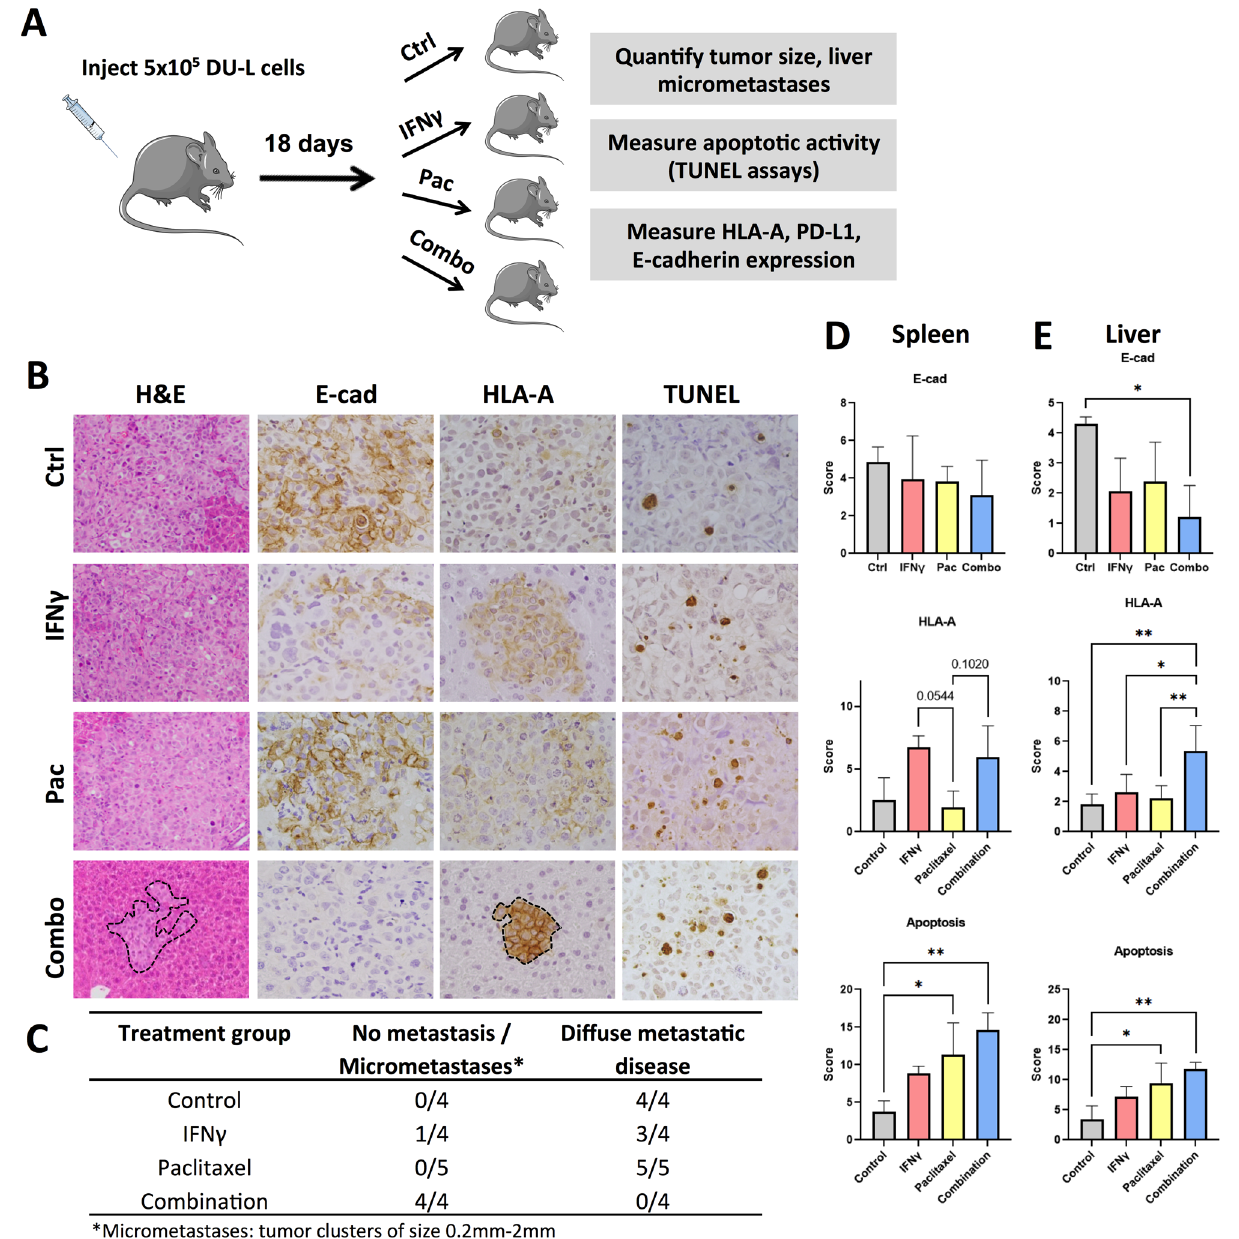
Figure 3. Alterations in HLA-A and E-cadherin expression and chemosensitivity of mCRPC after IFNγ pretreatment in vivo. ( A ) Experimental outline to test the effect of IFNγ pretreatment on HLA-A and E-cadherin expression, as well as sensitivity to chemotherapy in DU-L cells in vivo. ( B ) Limited liver metastatic tumor growth of DU-L prostate cancer cells in IFNγ and paclitaxel combination group. H&E images at 200 × magnification and all others at 400 × magnification. Tumor is not outlined where the vast majority of the captured image is tumor. ( C ) Enumeration of liver metastasis in each mouse. ( D ) Representative H&E, HLA- A, E-cadherin and TUNEL staining in the metastatic tumors at completion of the study. ( E ) Quantification of HLA-A and E-cadherin expression, and TUNEL assays. Data shown as mean ± SD. Analysis of variance (ANOVA) or Kruskal–Wallis with Dunn’s multiple comparisons test after determination of normality based on Shapiro–Wilk test, * p < 0.05, ** p < treatment with IFNγ of mCRPC cells in vitro was associated with increased sensitivity to PAC (Fig. S8). Mouse weight was recorded prior to each drug injection to monitor for potential side effects; no obvious weight loss (> 5%) was observed in any of the mice. The mice were euthanized on day 30 after five rounds of PAC treatment. All the primary tumors that arose upon intrasplenic injection produced hepatic metastases with the excep- tion of one tumor treated with combination therapy, which did not lead to any detectable metastasis to the liver. Strikingly, all samples in control and PAC treatment groups, and 3/4 samples from IFNγ group, demonstrated a